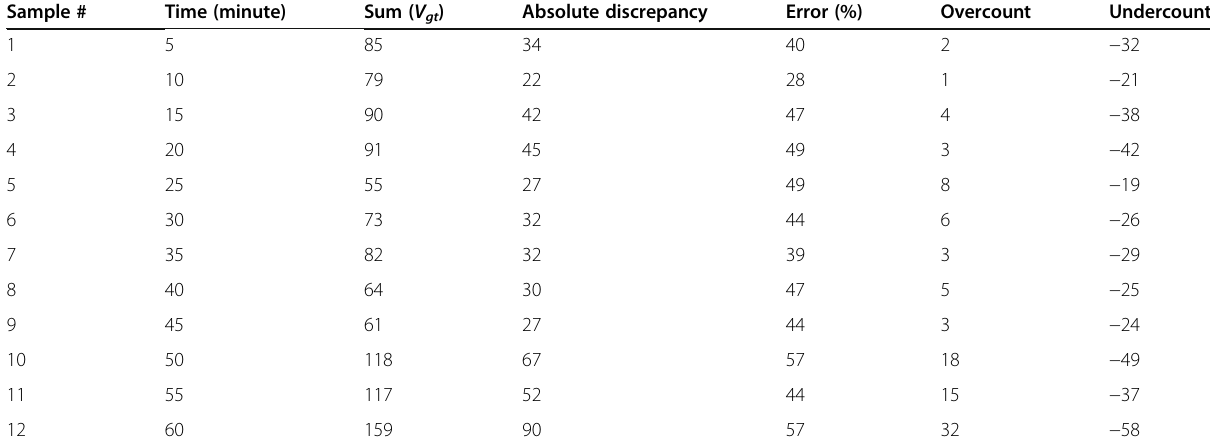
Table 1 Time, ground truth, discrepancy, error, overcount, and undercount for each sample Sample #